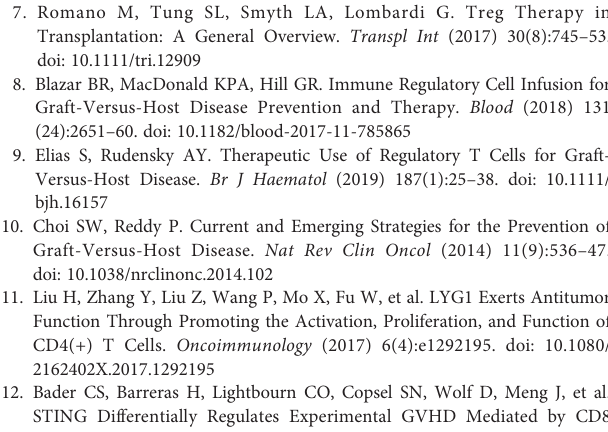
Supplementary Figure 1 | Gating strategies for fl ow cytometry analyses presented in Figure 1 . (A – C) The expression of CD69 (A) , IFN- g (B) and Foxp3 (C) in isotype (ISO) (left) and negative control without stimulating cells (right). Supplementary Figure 2 | Gating strategies for fl ow cytometry analyses in T cells before adoptive transfer presented in Figure 2 (A) . (B, C) Representative fl ow cytometry plots and frequencies of naive (CD44 lo CD62L hi ), central memory (CD44 hi CD62L hi ), effector (CD44 hi CD62L lo ) in CD4 + T cells and CD8 + T cells respectively. n=5pergroup. (D, E) ThepercentagesofCD3 + T,CD4 + TandCD8 + T cells in BM cells from donor mice before adoptive transfer. Supplementary Figure 3 | LYG1 de fi ciency reduced allogeneic T cells function in haploidentical transplant model. Splenocytes of recipient mice were isolated on day 14 after transplantation and analyzed by fl ow cytometry. (A, B) The percentages of CD69 expression in CD4 + T cells and CD8 + T cells. (C, D) The percentages of IFN- g expression in CD4 + T cells and CD8 + T cells. (E, F) The percentages of Foxp3 expression in CD4 + T cells and CD8 + T cells. n=5 per group. Supplementary Figure 4 | Gating strategies for fl ow cytometry analyses presented in Figure 3 . The expression of CD69 (A, B) , CD44 and CD62L (C, D) , IFN- g (E, F) and Foxp3 (G, H) in CD4 + T cells and CD8 + T cells respectively in ISO (left), BM control (middle) and Syn control (right). Supplementary Figure 5 | The concentrations of IFN- g , TNF- a and IL-6 in serum in aGVHD models. (A) The concentrations of IFN- g , TNF- a and IL-6 in serum at day 7 after transplantation in major MHC mismatched aGVHD model. (B) The concentrations of IFN- g , TNF- a and IL-6 in serum at day 14 after transplantation in haploidentical model. (C, D) The concentrations of IFN- g , TNF- a and IL-6 in serum at day 7 after transplantation in puri fi ed CD4 + T cells or CD8 + T cells. n=4-5 per group. Statistical results are expressed as the mean ± SD, *p< 0.05 compared with Lyg1 +/+